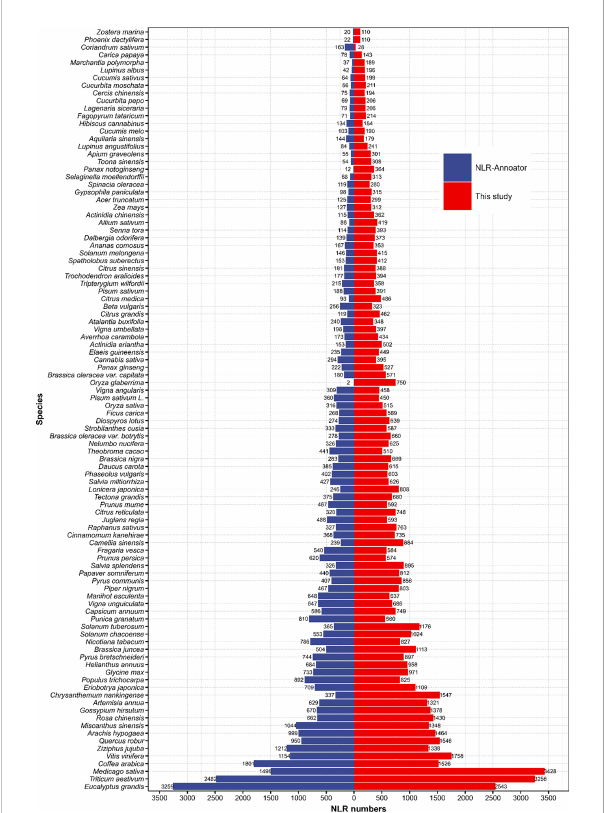
FIGURE 2 Comparison of NLR genes discovered using both our pipeline and NLR-Annotator. The blue bar shows the number of NLRs identi fi ed by NLR-Annotator. The red bar shows the number of NLRs identi fi ed by our